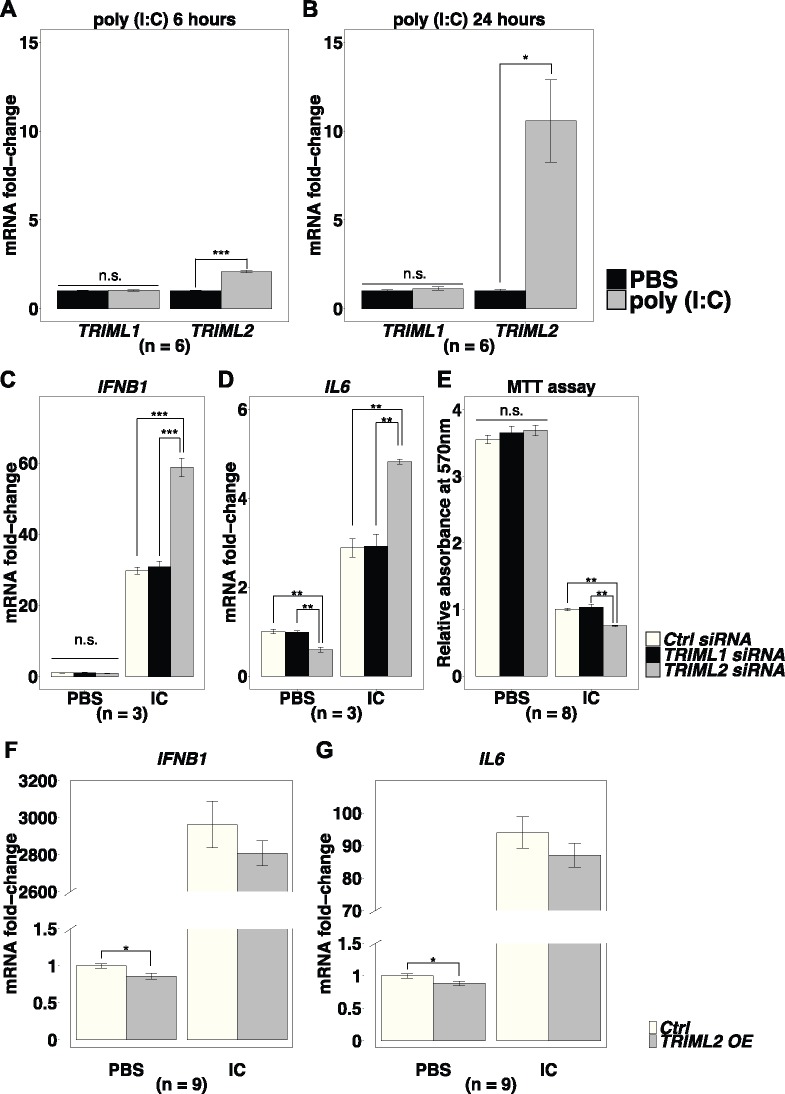

TRIML2 during trophoblast inflammation. (A and B) TRIML2 expression in JEG3 is induced by poly(I:C). (C–E) TRIML2 knockdown during inflammation causes increased expression of proinflammatory cytokines IFNB1 (C) and IL6 (D), and decreased survival of JEG3 cells (E). TRIML2 overexpression reduces IFNB1 (F) and IL6 (G) expression at baseline. Normalized to PBS-treated control groups; IC, poly(I:C), OE, overexpression. Values are mean ± SEM. (A, B, F, and G), t-test. (C and D) One-way ANOVA, Tukey’s HSD. Poly(I:C) treatment in (E), Kruskal–Wallis test, Bonferroni post hoc correction. ***P < 0.001, **P < 0.01, *P < 0.05. n.s., not statistically significant.